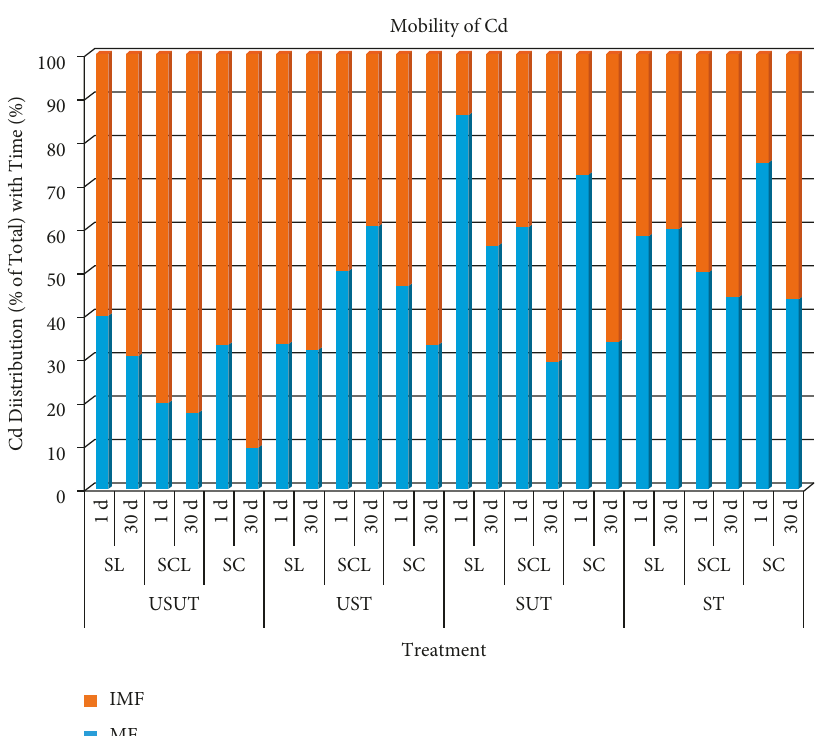
Figure 5: Changes in the mobile and immobile fraction of cadmium in three soils with time. SL - silt loam soil, SCL - silty clay loam soil, SC - silty clay soil, USUT- unspiked untreated, UST- unspiked treated with OM, SUT- spiked untreated with OM, ST- spiked treated with OM, MF- mobile fractions, IMF- immobile